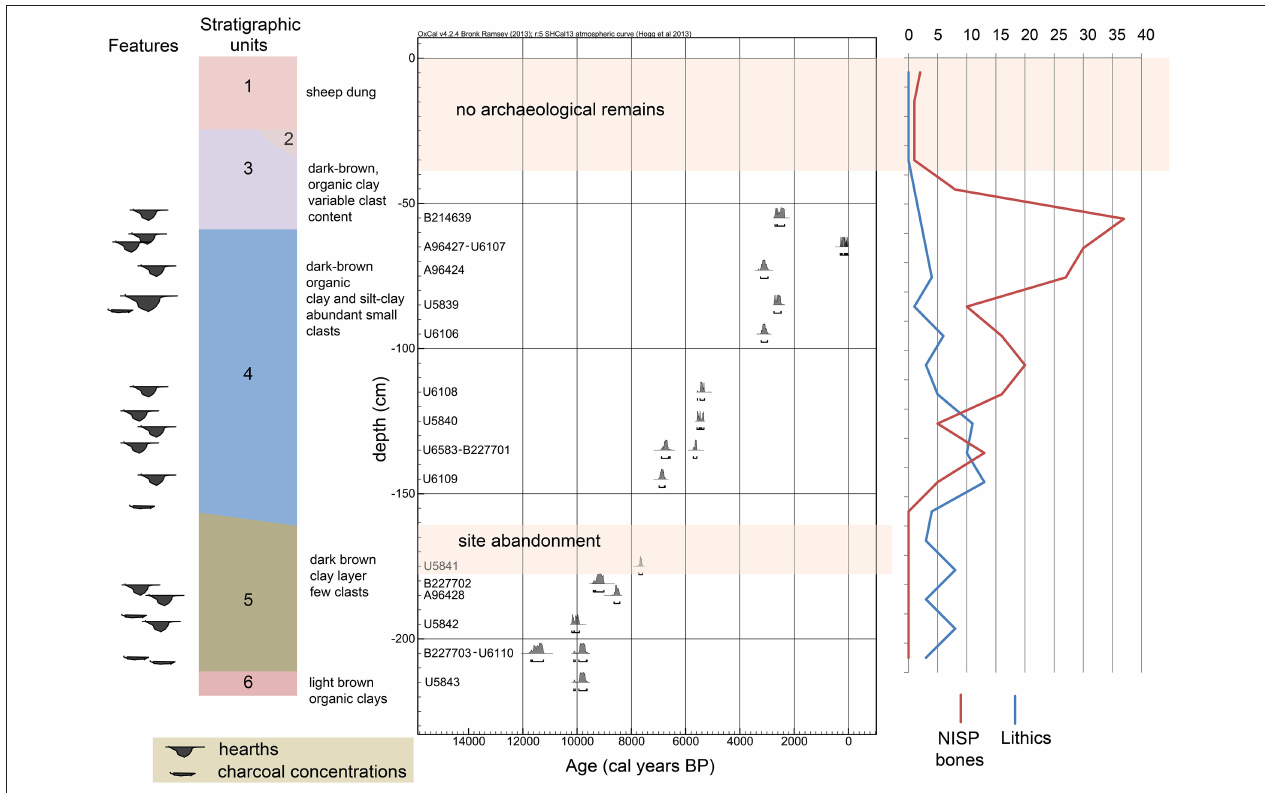
FIGURE 7 | El Chueco 1 schematic stratigraphy, features, 14 C age depth plot, and frequencies of lithic artifacts and bone remains